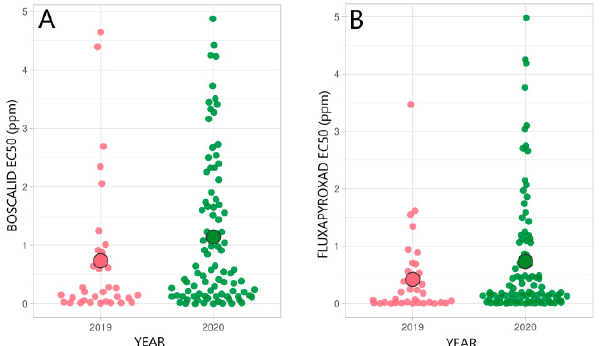
Figure 3. Distributions of the SDHI-fungicide sensitivity of R. collo-cygni to boscalid ( A ) and fluxap- yroxad ( B ) in 2019 and 2020 in Estonia. ○ shows the average EC 50 value (ppm) in a population [20].